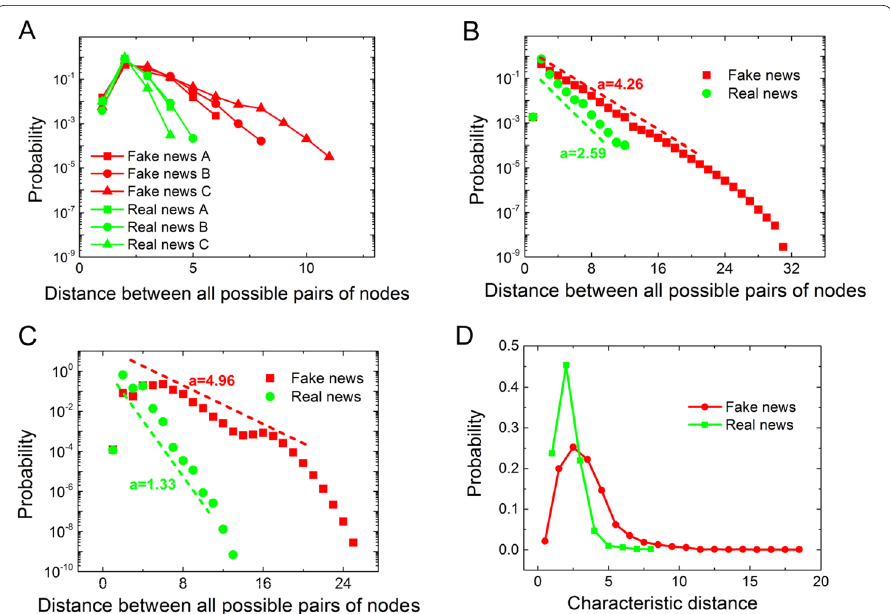
Figure 4 Characteristic distance differentiates fake news from real news. ( A ) The PDF of distances for three typical examples of networks for both fake and real news in Weibo. ( B ) The PDF of distances for all real and fake news networks in Weibo. ( C ) The PDF of distances of all real and fake news networks in Twitter. ( D ) The PDF of the characteristic distances ( detailsinMethods ) for fake news and real news. The p -value between fake and real news is below